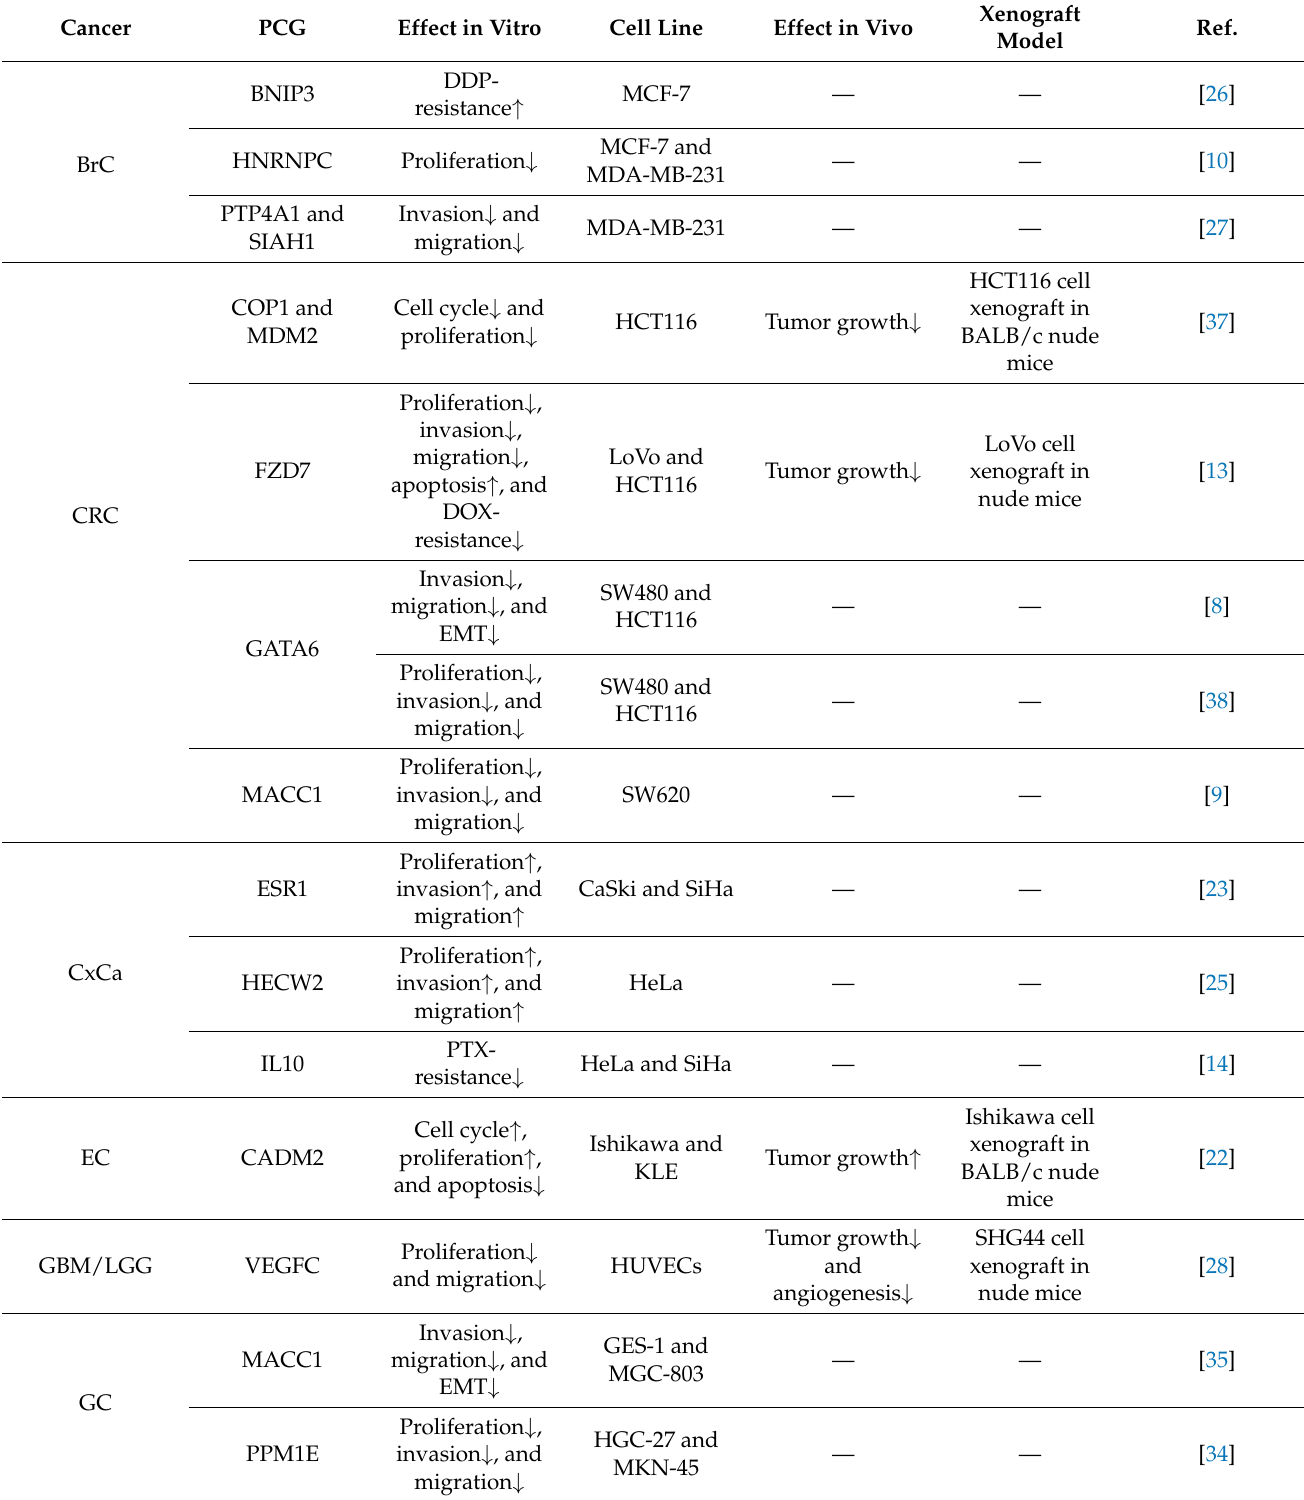
Table 3. The target genes of miR-944 and cell